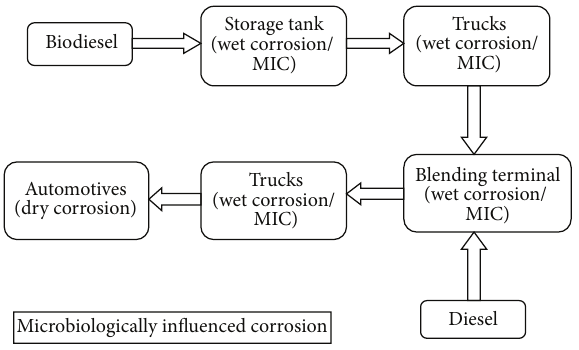
Figure 1: Corrosion types and locations.